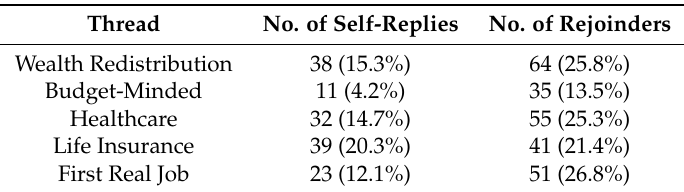
Table 5. Self-replies and